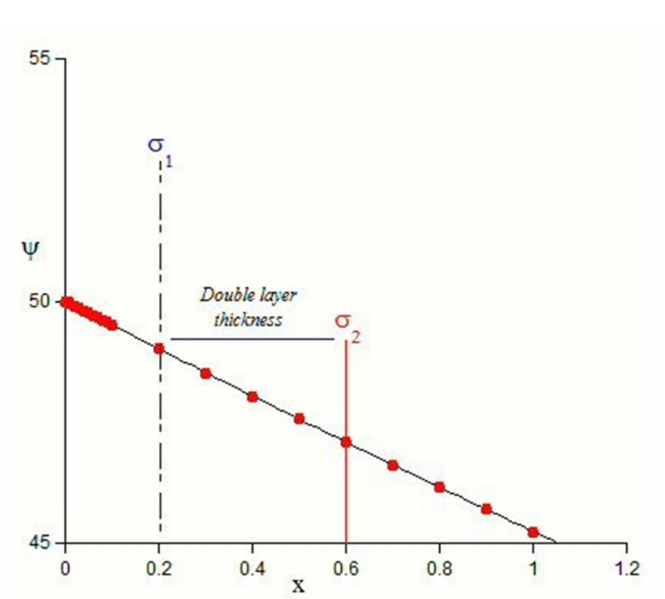
Figure 6. The decay of electrostatic potential, Ψ , and the surface charge density, σ , versus distance, x: the distance among the points having charge density equal to σ 1 and σ 2 , the double layer thickness, or Debye’s screening length, depends on the medium ionic